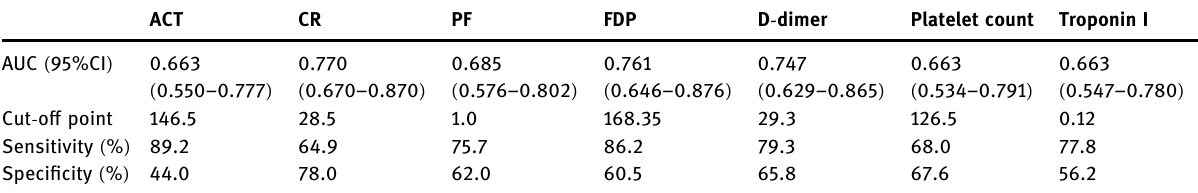
Table 4: Areas under receiver operating characteristic curves ( AUC ) and cut - o ff points to predict return of spontaneous circulation ACT CR PF FDP D - dimer Platelet count Troponin I AUC ( 95%CI )